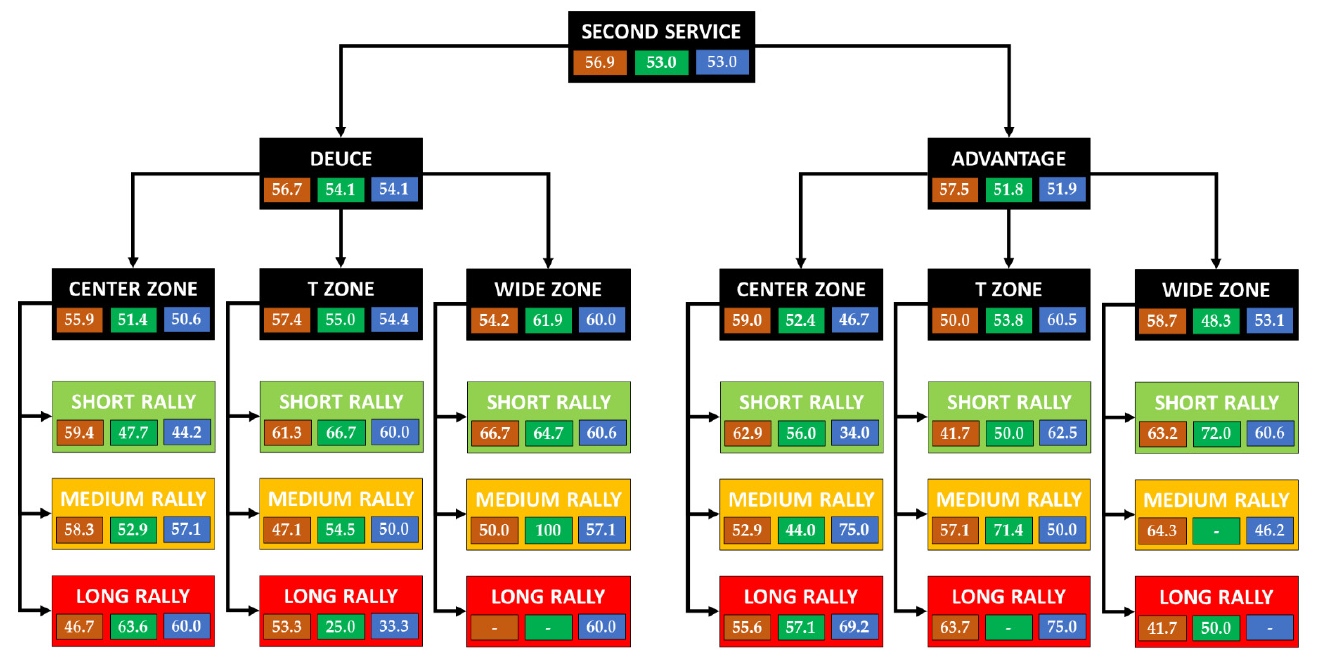
Figure 6. Efficiency analysis with the second service.